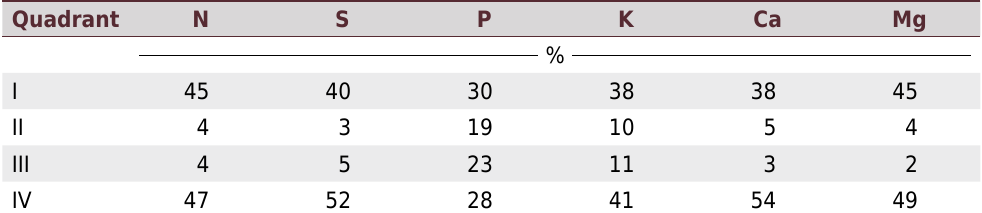
Table 5. Percentage of plots in each quadrant according to the criteria established by the Quadrant Diagram of the Plant-Soil Relationship (QDpsR) method Quadrant N S P K Ca Mg %